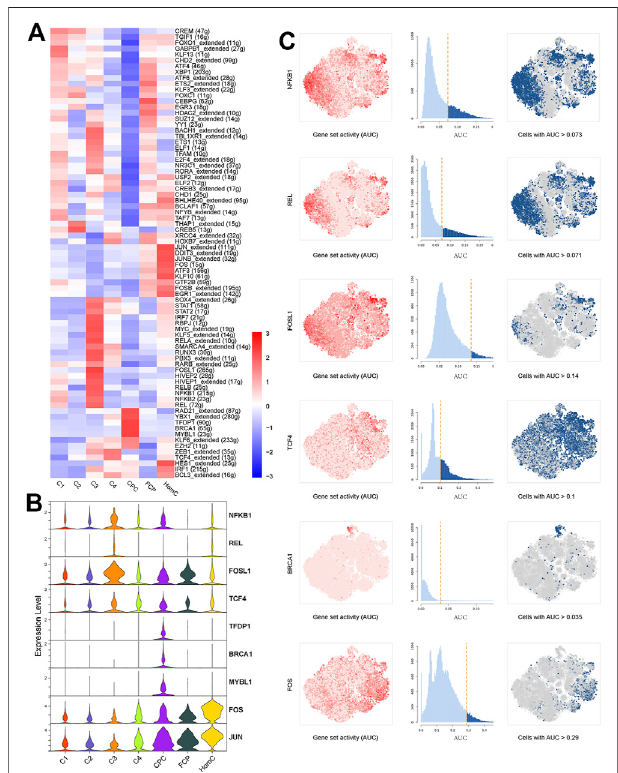
FIGURE 3 | Transcriptional regulation of seven chondrocyte subclusters. (A) Heatmap indicating the expression regulation by TFs analyzed with SCENIC in seven chondrocyte subclusters. Numbers between brackets indicate the (extended) regulons for respective TFs. (B) Violin plots showing the expression levels of representative candidate TFs across the seven chondrocyte subclusters. (C) SCENIC analysis predicts selected TFs as central hubs governing the different chondrocyte subclusters. TF regulon activities were quanti fi ed using AUCell. TFs, transcription factors; SCENIC, single-cell regulatory network inference and clustering; CPC, cartilage progenitor cells; FCP, fi brochondrocyte progenitors; HomC, homeostatic